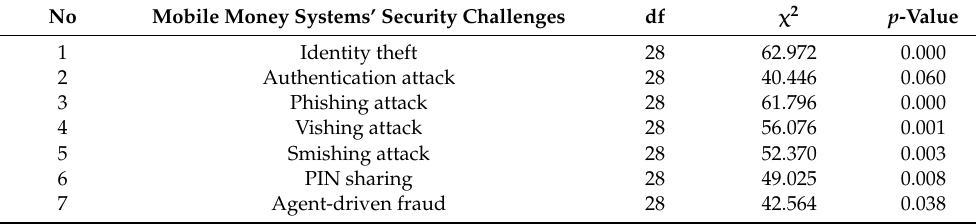
Table 7. Relationship between education level and mobile money systems’ security